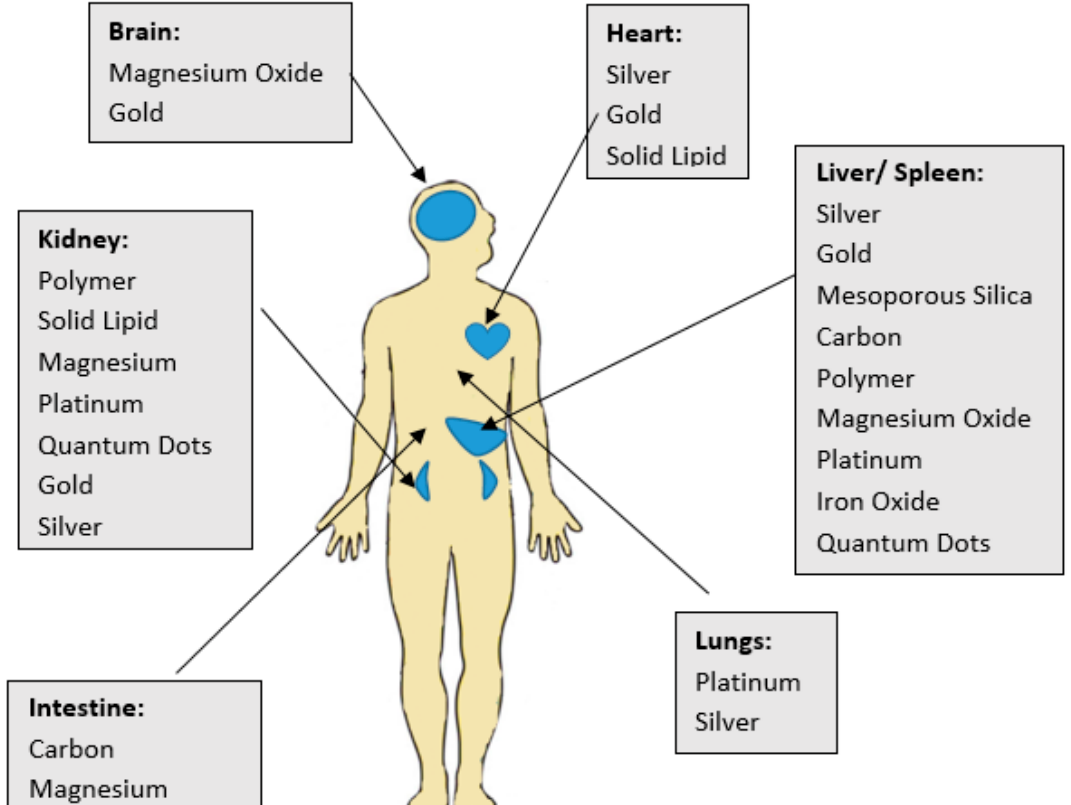
Figure 2. Summary of the distribution of nanoparticles (NPs) in vivo.